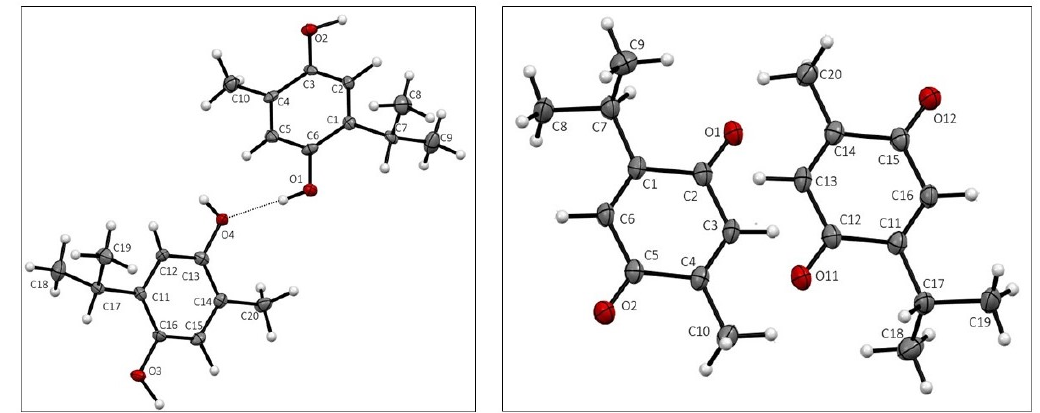
Figure 1. Asymmetric unit of THQ, left, and TQ, right, with atom labeling.